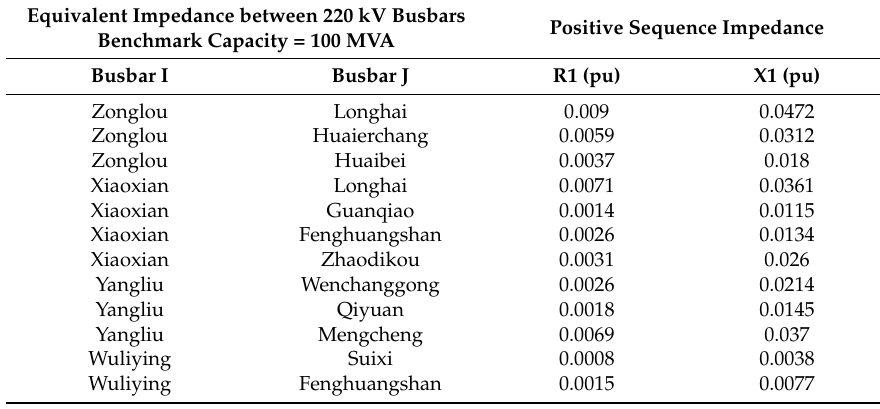
Table A2. 220 kV branch impedance